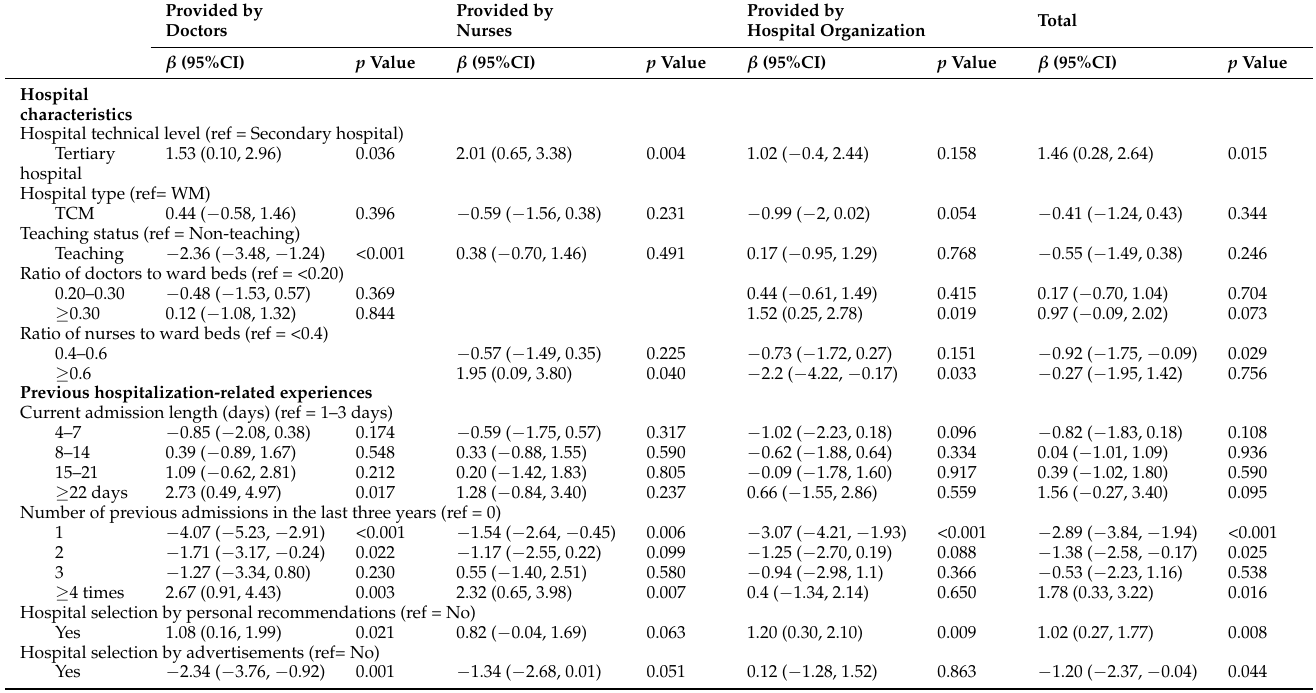
Table 3. Multivariate linear regression model to examine the association of hospital characteristics and patients’ previous hospitalization-related experiences with patients’ perceptions of hospital